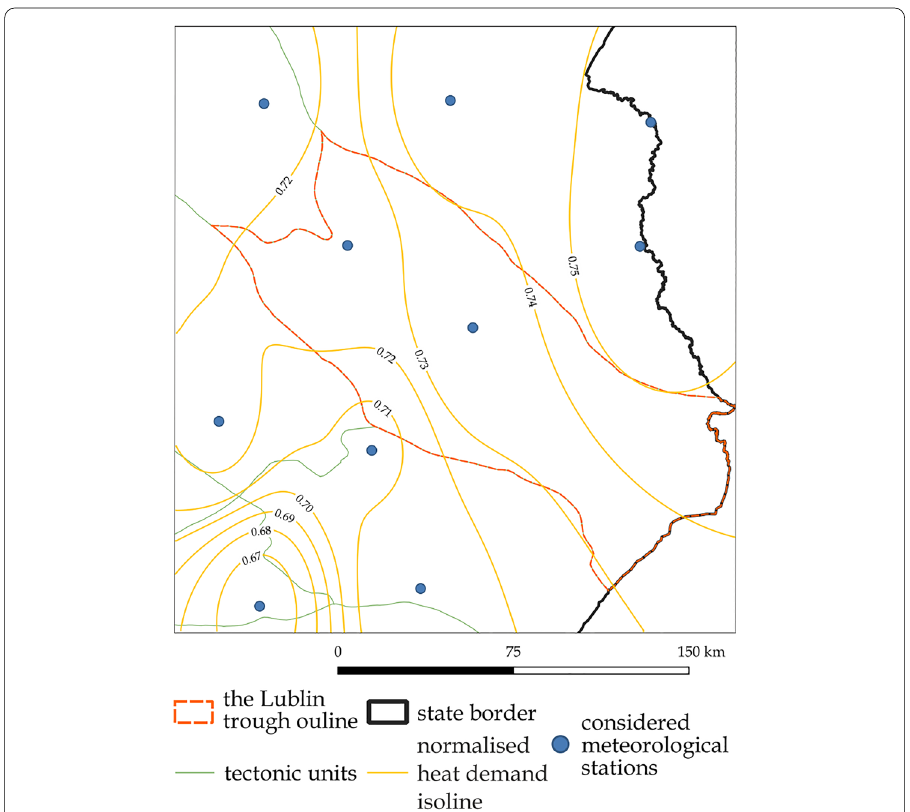
Fig. 6 Normalised heat demand in an exemplary hour. Map presents heat demand in the considered area. Values for a given hour in marked stations (blue dots) were interpolated in GIS software with Inversed Distance Weight (IDW) algorithm with weight parameter set as 3.0. Yellow solid lines mark isolines of normalised heat demand, orange dashed line presents the Lublin trough boundary and green lines represent tectonic units in the map extend within Poland (black solid